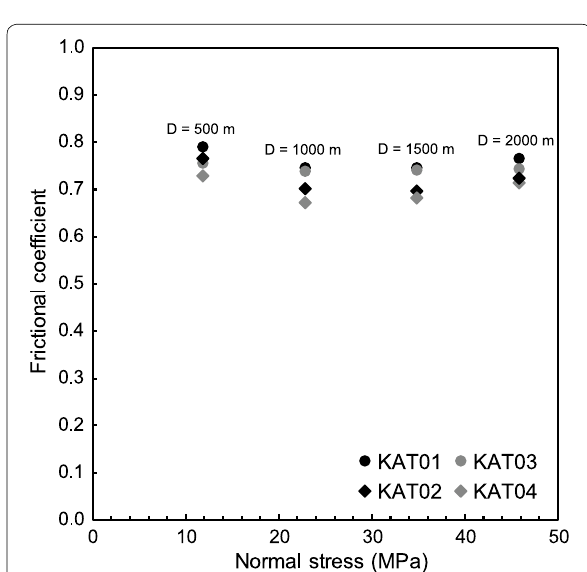
Fig. 4 Friction coefficients of fault gouges (KAT01, 03) generated by bedding-plane slip and of mudstones (KAT02, 04). Double-direct shear tests of four samples (KAT01, 02, 03, and 04) on two sliding planes were performed as in previous studies (Kawai et al. 2015). D: